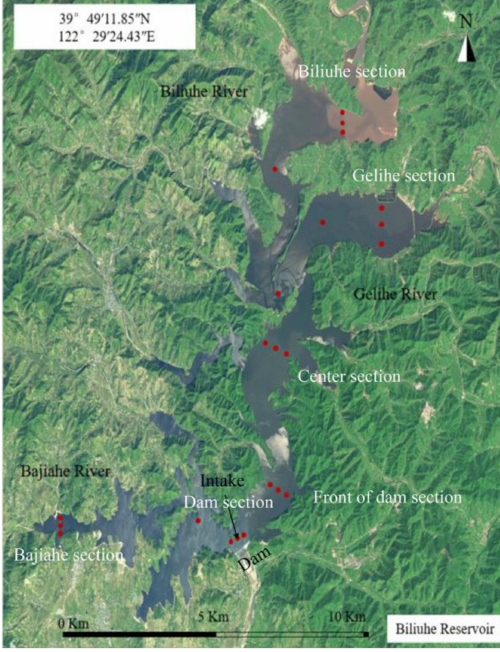
Figure 1. Distribution of monitoring sections and points in the Biliuhe